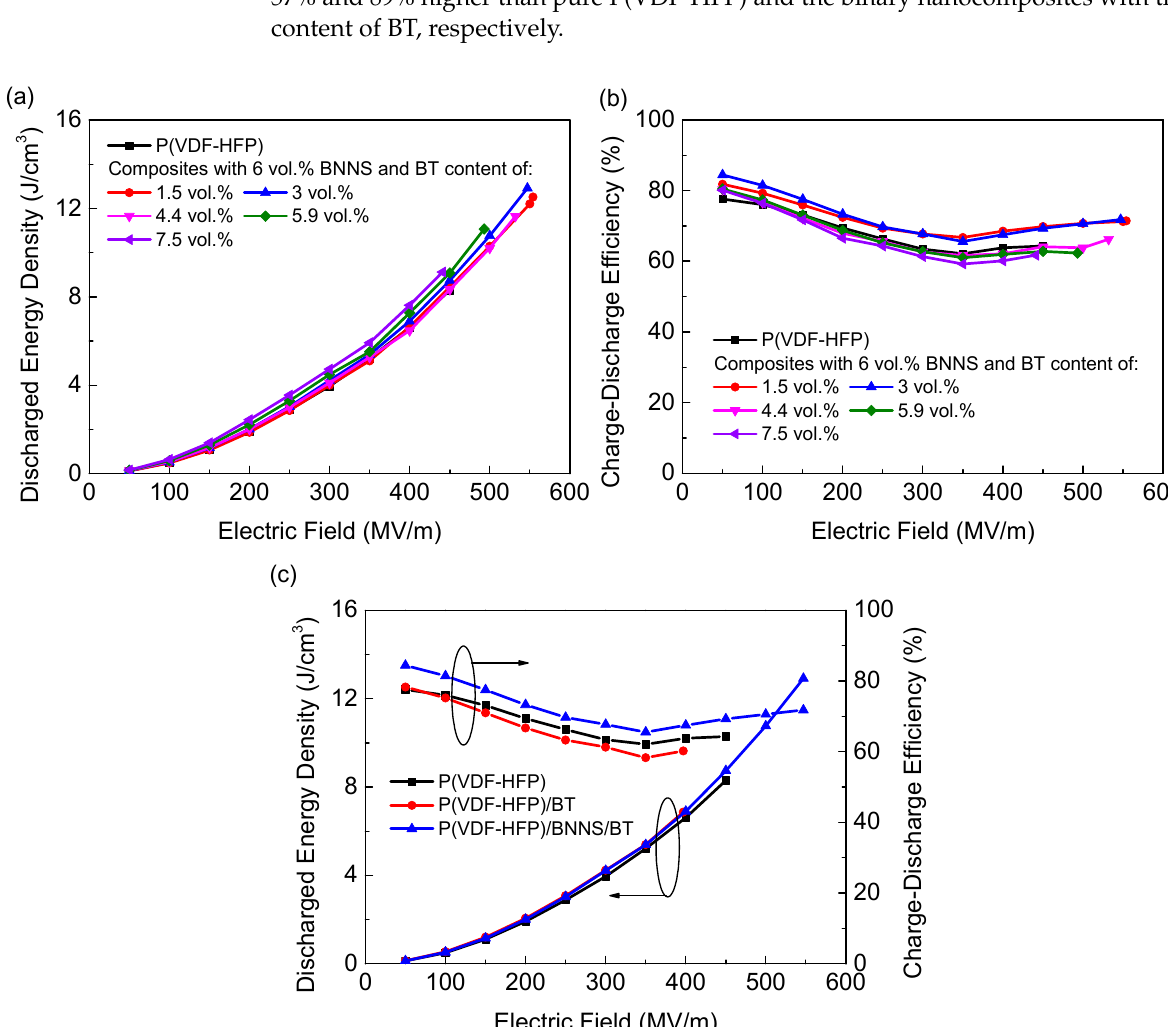
Figure 6. ( a ) Discharged energy density of the ternary nanocomposites with 6 vol.% BNNSs and various content of BT. ( b ) Charge–discharge efficiency of the ternary nanocomposites with 6 vol.% BNNSs and various content of BT. ( c ) Discharged energy density and charge–discharge efficiency of pure P(VDF-HFP), binary nanocomposites, and ternary nanocomposites under different electric fields.